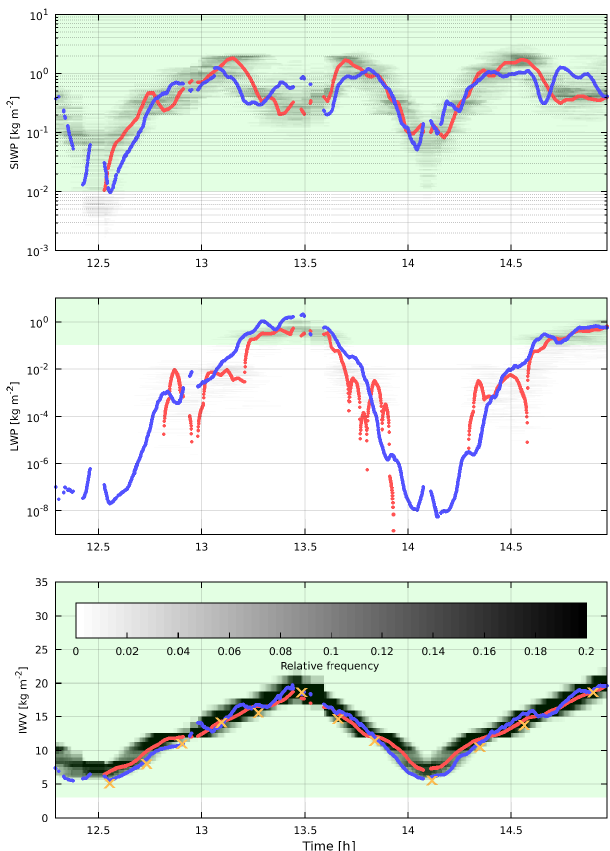
Figure 8. Time series of the retrieved SIWP, LWP, and IWV. The time series of the retrieved SIWP, LWP, and IWV are shown as blue lines. The time series of the ICON model SIWP, LWP, and IWV for the time and location of the FAAM during flight B897 are shown as red lines. Time series of histograms of the ICON model SIWP, LWP, and IWV are plotted as grey shades underneath; see text for details. The green shaded areas marks the range where the retrieval is offset-free according to Sect. 4. The orange crosses indicate the IWV from the dropsonde